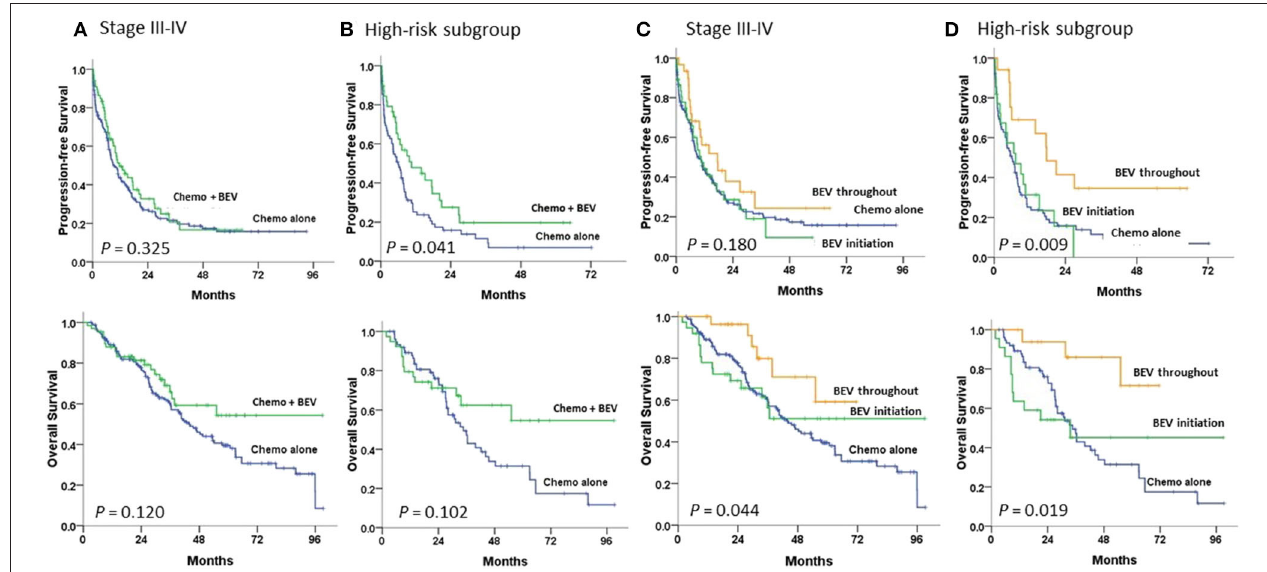
FIGURE 2 | Progression-free and overall survival in (A,C) stage III–IV patients and (B,D) high-risk patients undergoing first-line therapy, tested by the log-rank test. (A,B) between chemotherapy (Chemo) with and without bevacizumab (BEV); (C,D) between Chemo with BEV throughout, BEV initiation, and Chemo alone.